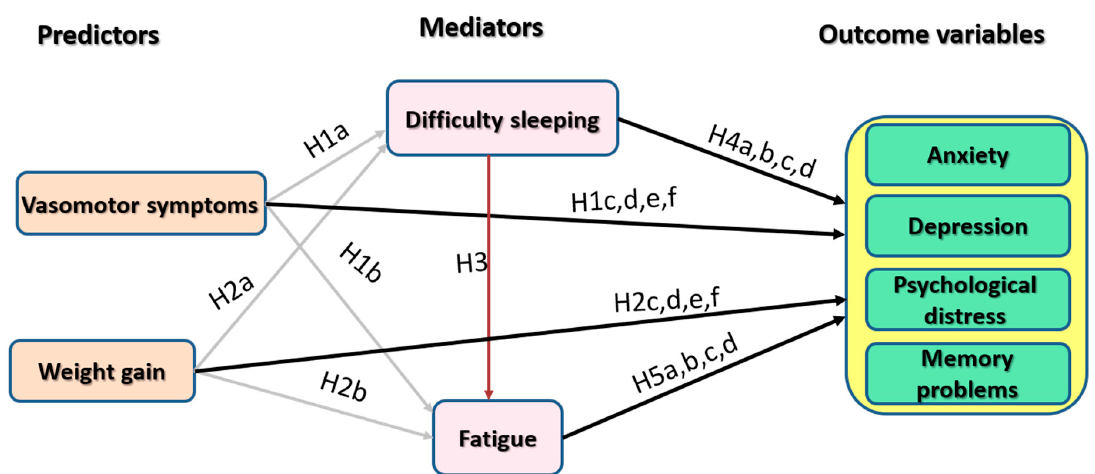
Figure 1. Hypothesized model of the relationships between vasomotor symptoms, weight gain, difficulty sleeping, fatigue, and psychological variables.